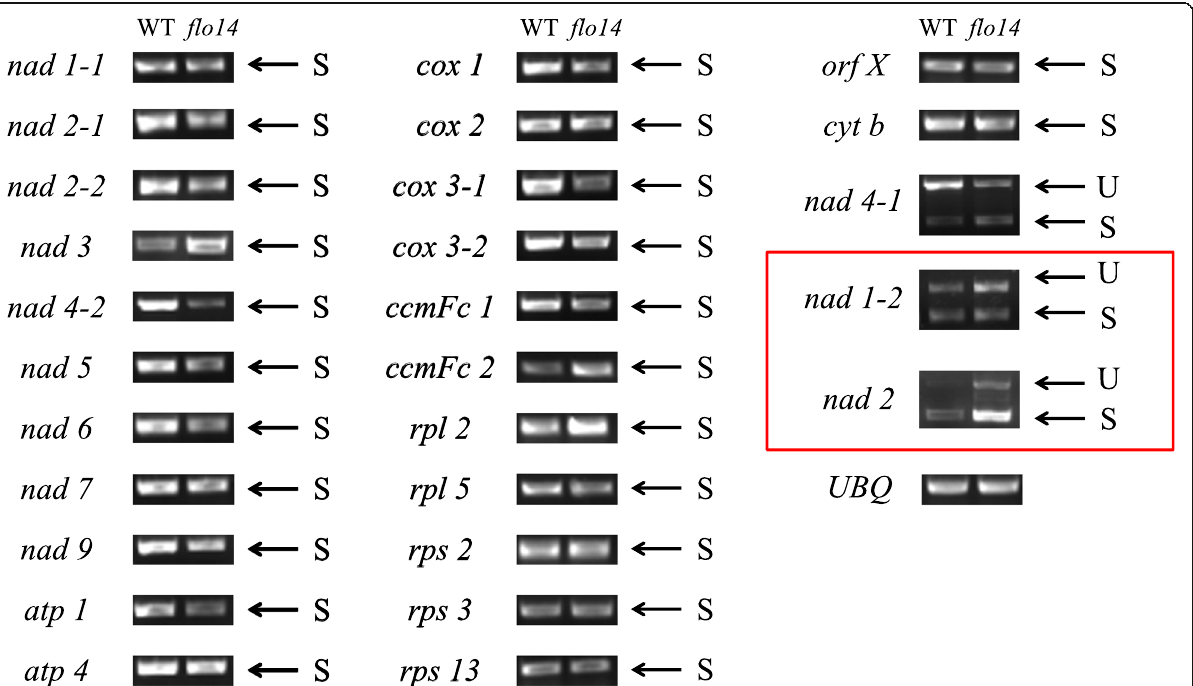
Fig. 9 The flo14 mutant is defective in the splicing of mitochondria genes. Gene transcripts are labeled at the left. Spliced (S) and unspliced (U) transcripts are shown at the right. RNA were extracted from 12 days after flowering (DAF) endosperms of wild type (WT) and flo14 mutant ( flo14 ). The splicing genes are tagged with red boxes. UBQ was used as a quantitative control. Nad 1 – 1: NADH dehydrogenase subunit 1 – 1, nad 1 – 2: NADH dehydrogenase subunit 1 – 2, nad 2: NADH dehydrogenase subunit 2, nad 2 – 1: NADH dehydrogenase subunit 2 – 1, nad 2 – 2: NADH